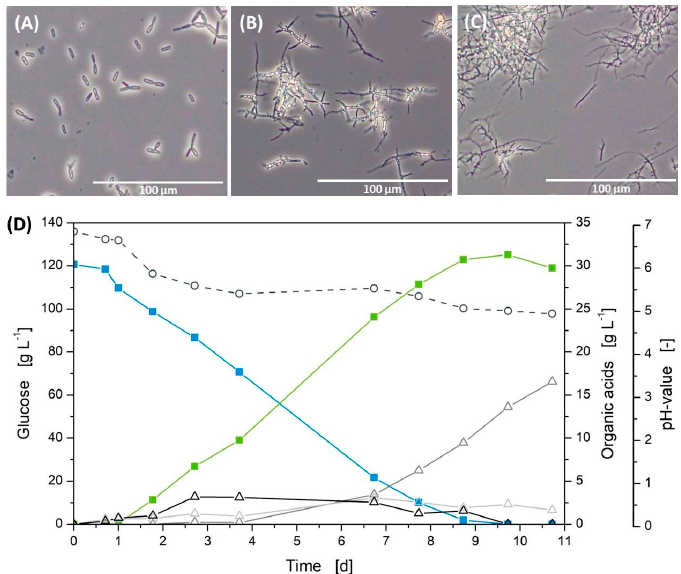
Figure 1. Cultivation of U. rabenhorstiana in 250 mL shake flasks in standard Tabuchi-medium ( D ) and its corresponding morphology ( A ): 0–2 days; ( B ): 2–7 days; ( C ): 7–11 days. Glucose (blue square), itaconic acid (green square), α -ketoglutaric acid (grey triangle), succinic acid (black triangle), malic acid (light grey triangle), pH (black circle), 120 rpm, 30 °C, 1% ( v/v ) inoculum.